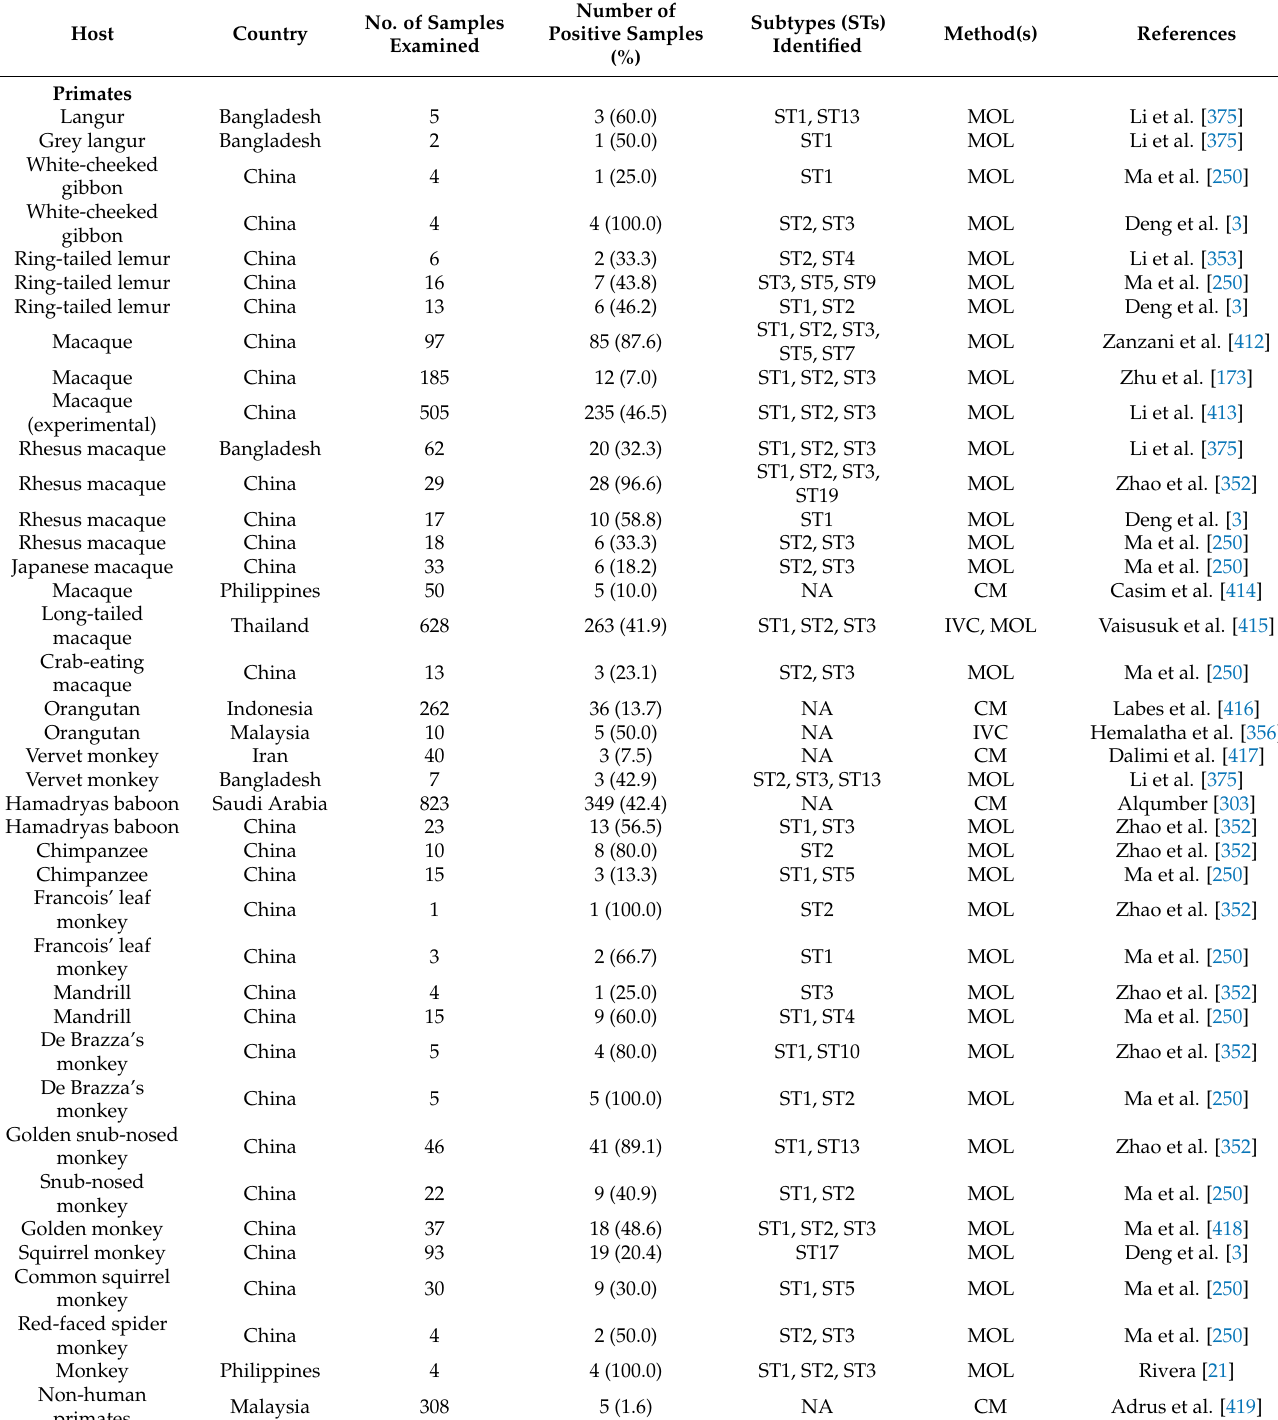
Table 11. Prevalence and subtype distribution of Blastocystis spp. in non-human primates in Asia